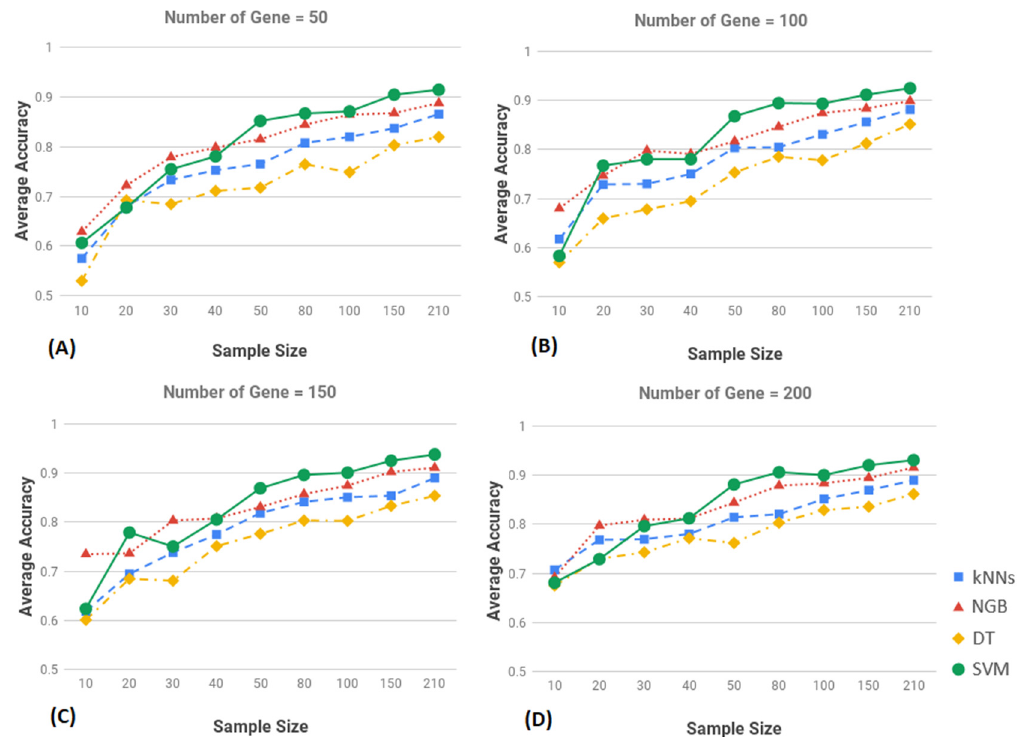
Figure 2. Classification average accuracy of machine learning (ML) methods of different training sample and top k-gene markers, k = 50 ( A ), k = 100 ( B ), k = 150 ( C ), and k = 200 ( D ), where k is the number of the top most highly significant genes used for various algorithms in each subfigure, on the training and the test sets of breast cancer (BC). For each panel, the x -axis is the sample size used for training, and the y -axis represents the classification accuracy. The blue, red, yellow and green lines represent the K-nearest neighbors (kNNs), Naïve Bayes (NGB), Decision tree (DT) and Support Vector Machines (SVM) method, respectively.